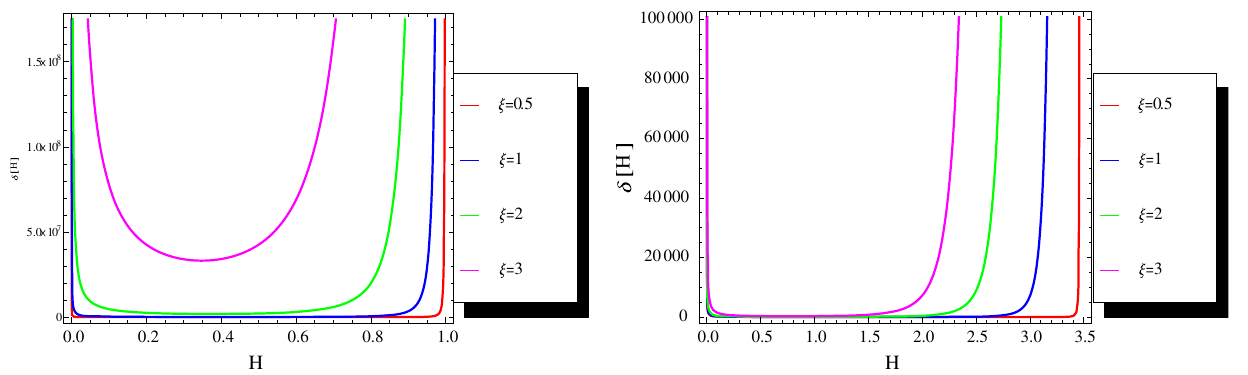
Fig. 6 The variations of bulk viscosity for Pseudo Rip singularity are plottedinthegraphatthelefthand-side(forfirstmodel)andinthegraph at the right hand-side (for second model) respectively for the fixed val- ues λ = 5 , H o = 1, h = 2, e = 12, ρ o = 0 . 9 and λ = 5 , H o = 1,